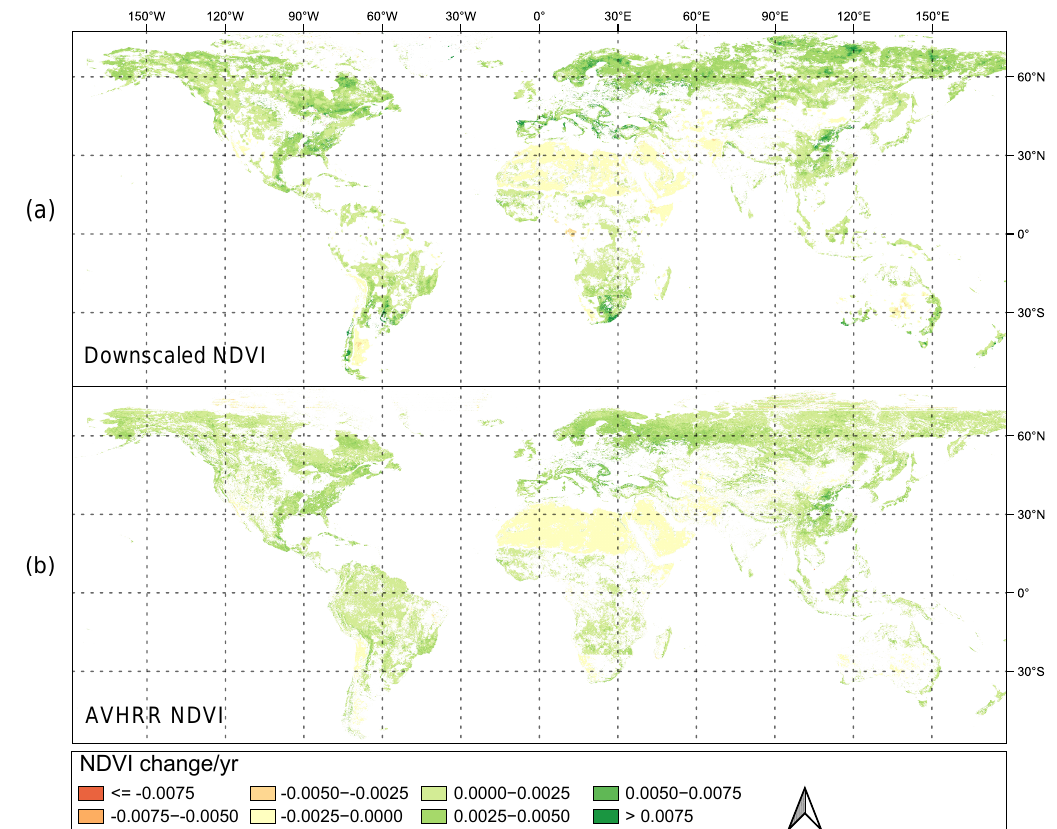
Figure 10. The global NDVI trends identified using Theil–Sen’s slope estimator based on the ( a ) down- scaled and ( b ) AVHRR NDVI for the period of 1982–2018. Please note that only the pixels having a significant trend ( p < 0.05) are